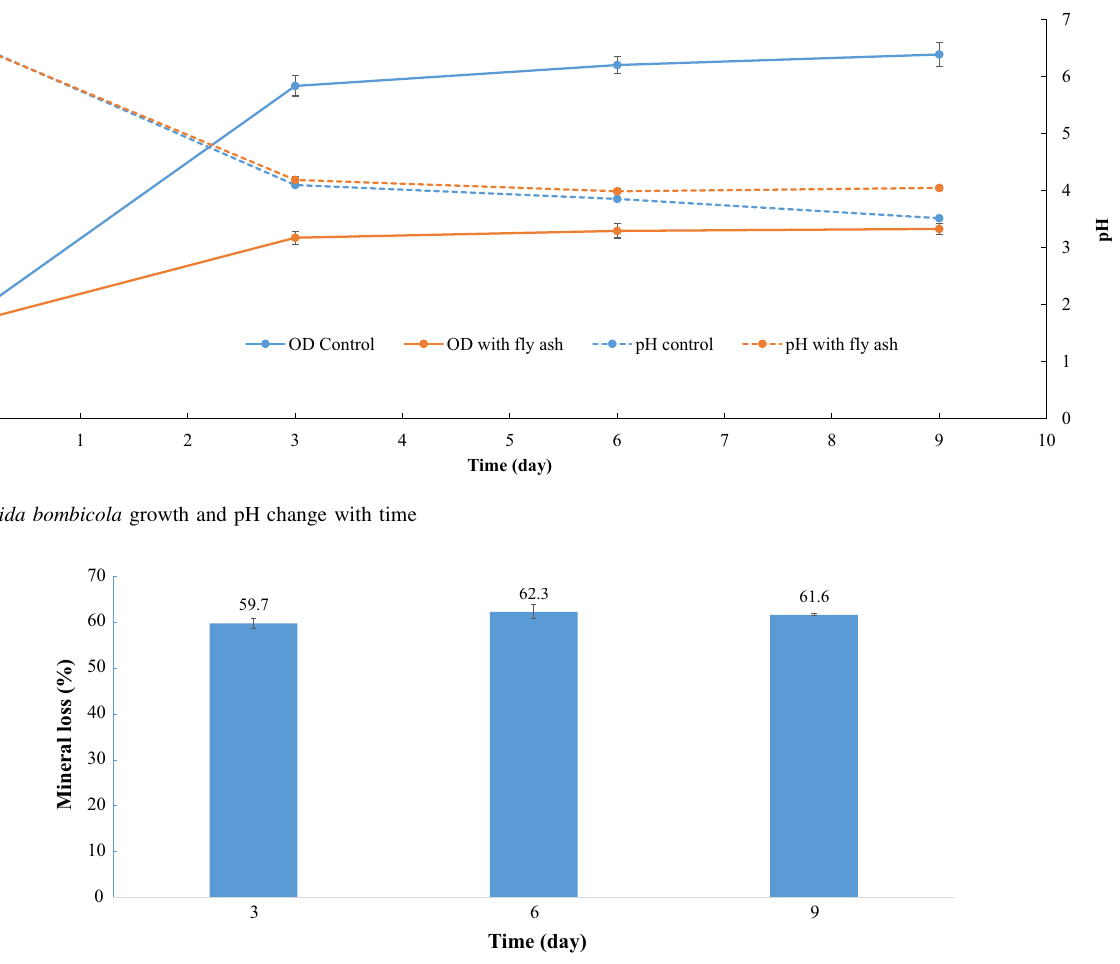
Fig. 7 Leaching efficiency of C. bombicola broth on fresh fly ash-effect of fermentation